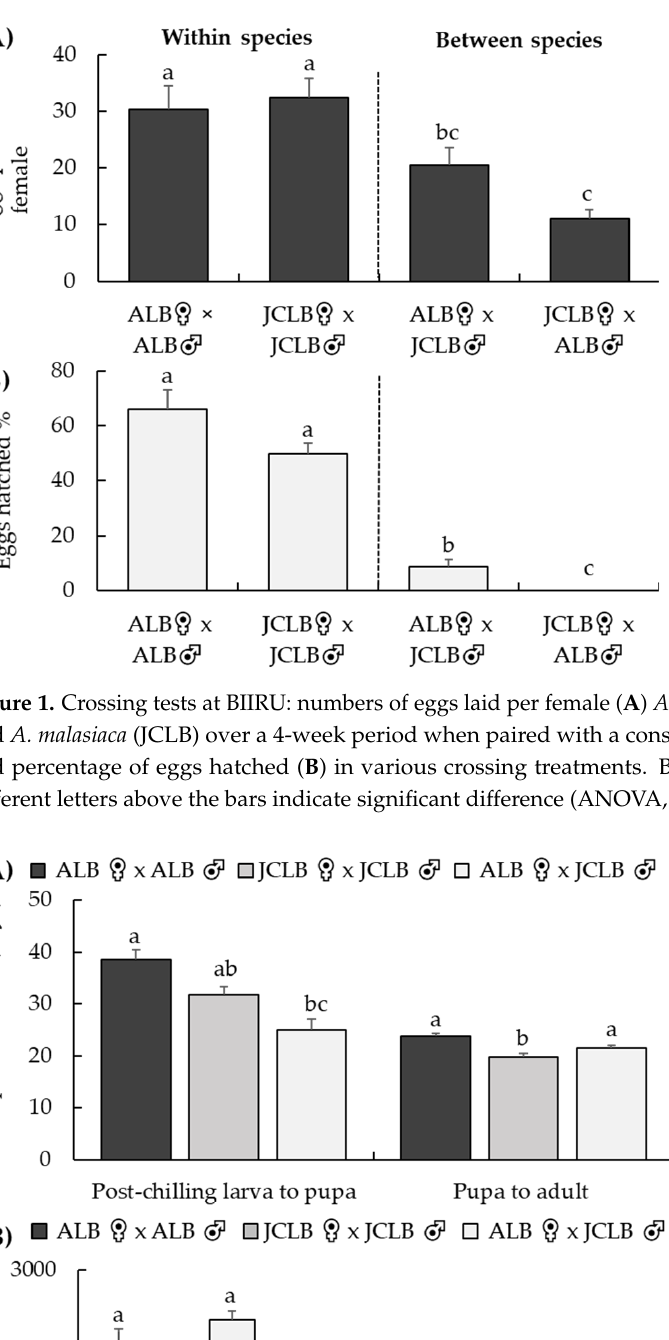
Figure 3. Adult female ( A ) and male ( B ) Anoplophora glabripennis (ALB), female ( C ) and male ( D ) A. chinensis (CLB), female ( E ) and male ( F ) A. malasiaca (JCLB), and female ( G ) and male ( H ) hybrids of ALB and JCLB. Arrows point to the smooth (ALB) or grainy (CLB, JCLB or the hybrid) surface of the basal portion of the elytra (a) or the presence of two white spots on the pronotum in JCLB or the hybrid (b).